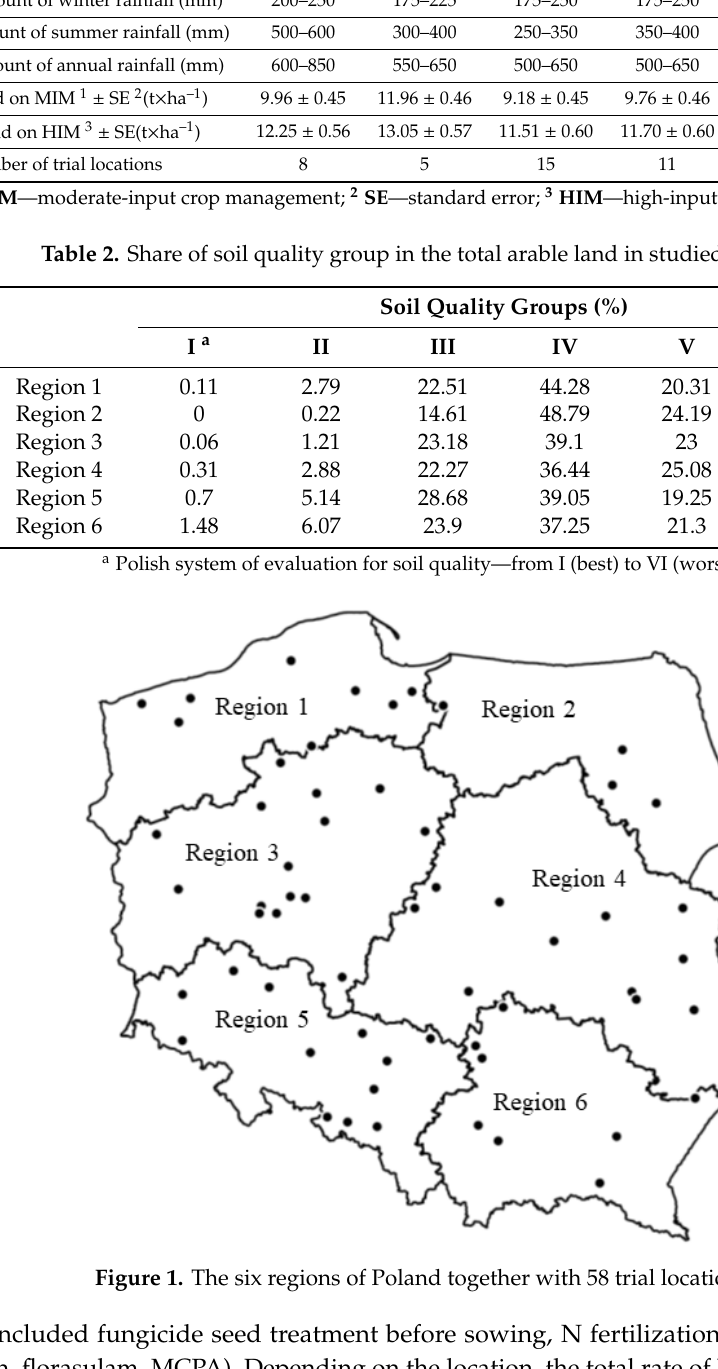
Figure 1. The six regions of Poland together with 58 trial locations.